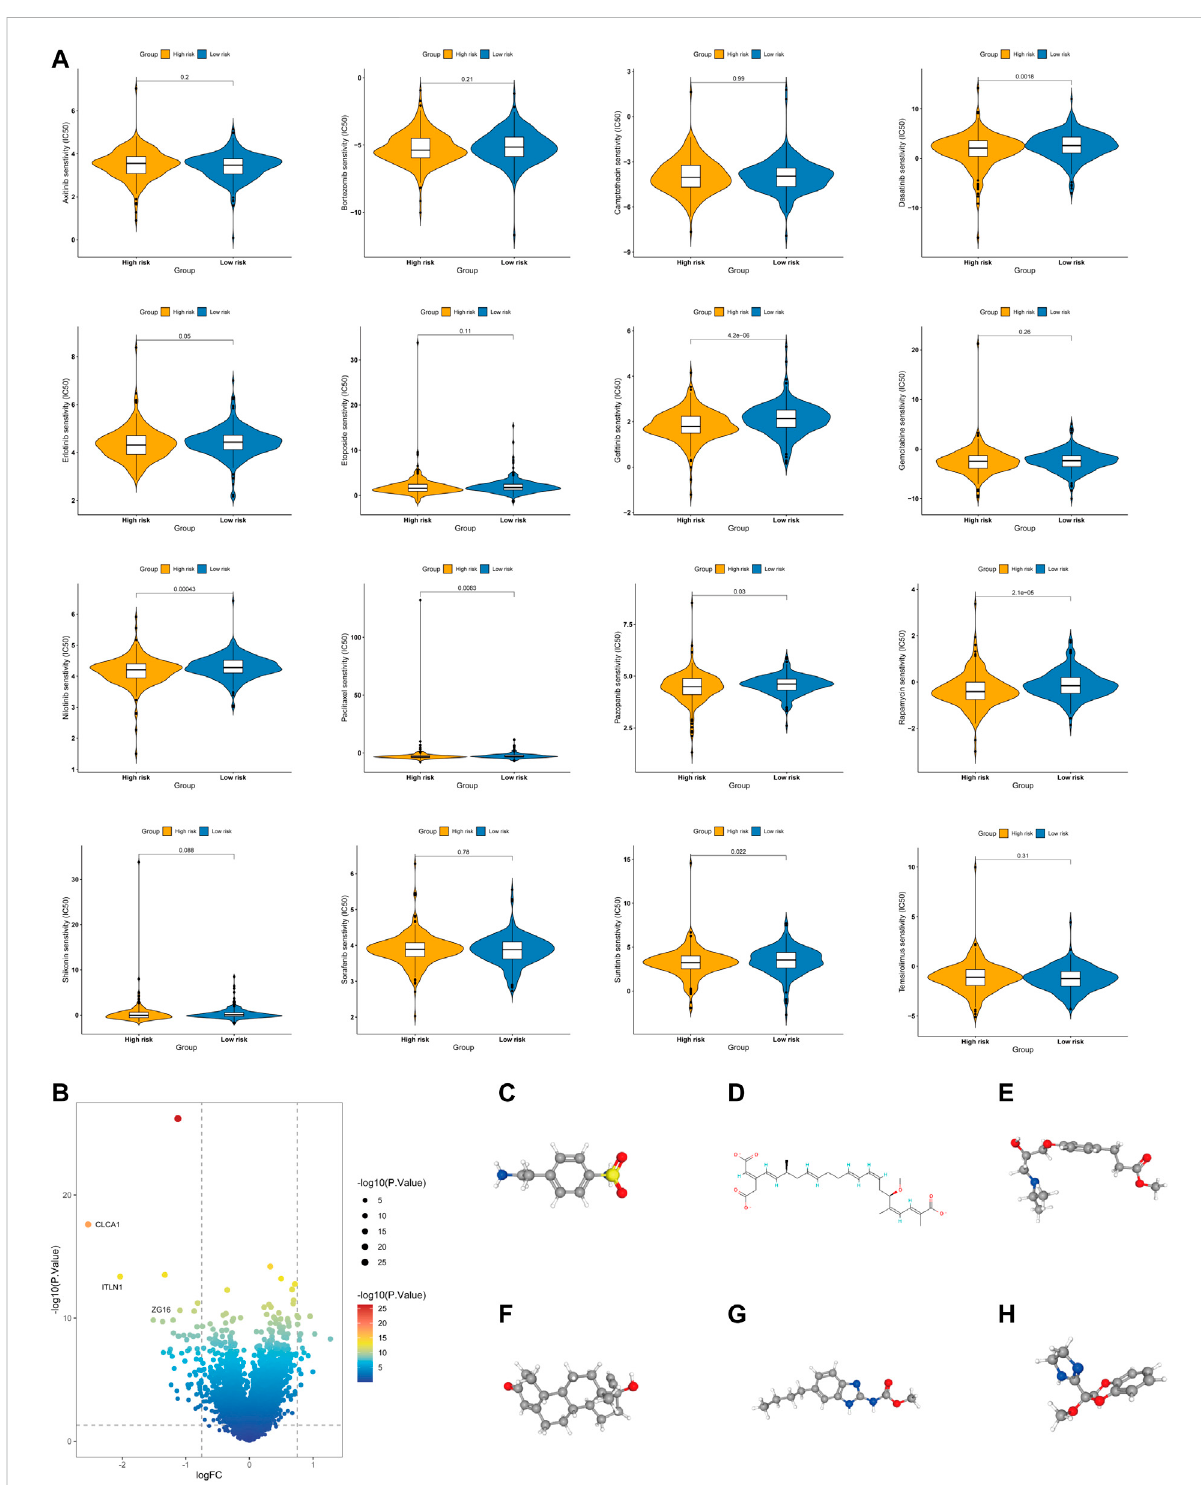
FIGURE 10 Evaluation of the chemotherapy response and screening of small-molecule drugs. (A) Sensitivity analysis of chemotherapy drugs between the high-andlow-riskgroups. (B) VolcanoplotofDEGsbetweenthehigh-andlow-riskgroups. (C – H) Structuresofsixsmall-moleculedrugcandidates, namely, 4-(2-aminoethyl) benzenesulfonamide (C) , bongkrek acid (D) , esmolol (E) , norethisterone (F) , parbendazole (G) , and RX-821002 (H)